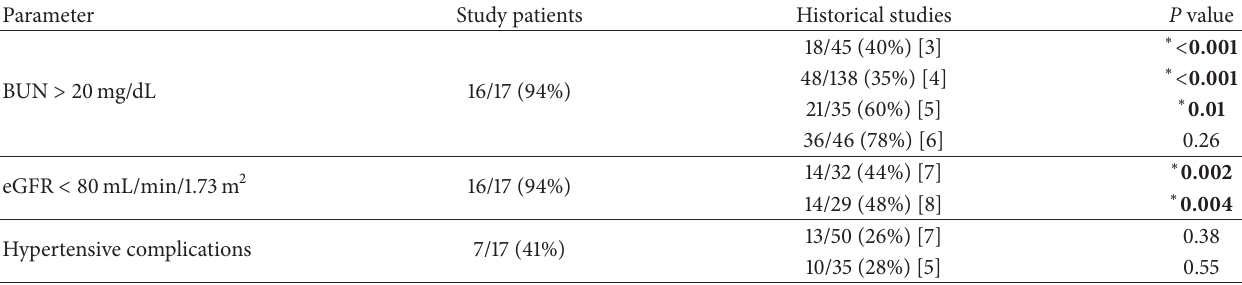
Table 5: Comparison of study patients with historical studies in poststreptococcal